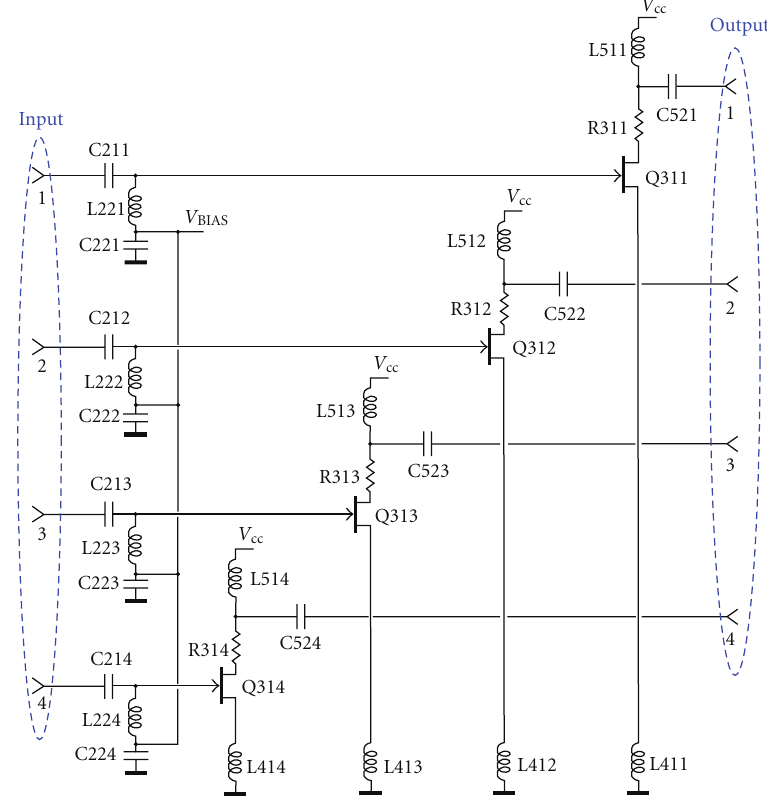
Figure 3: A low-noise MIPMOP amplifier comprising a MIMO-SSFA, 4 uncoupled input matching networks, and 4 uncoupled output matching networks.